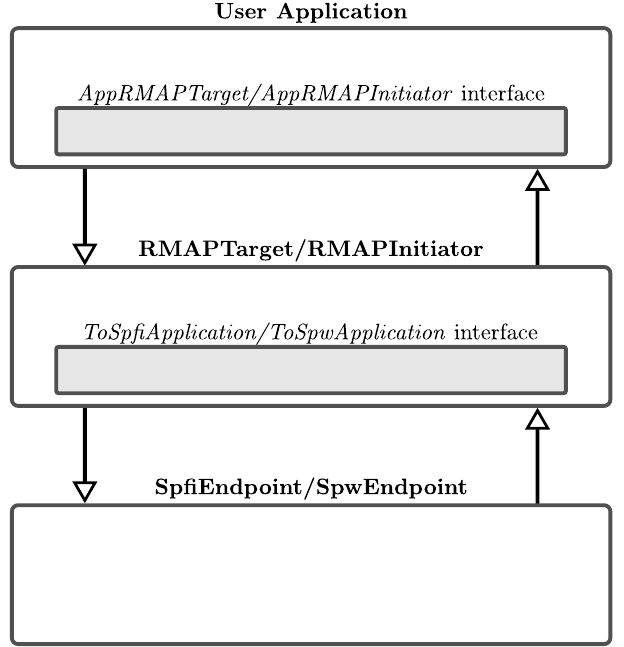
Figure 6. RMAP additional layer between the user application and the